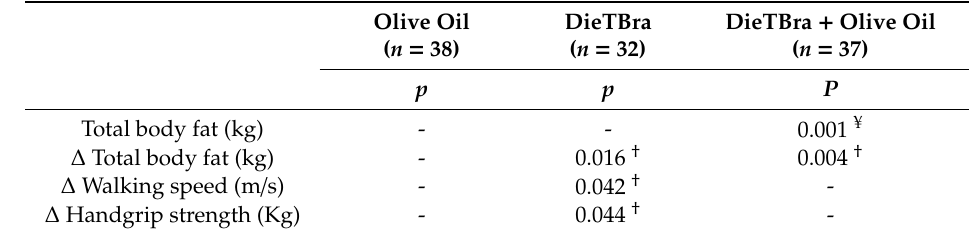
Table 5. Analysis of covariance for delta of outcome variables * with delta weight and delta time of sedentary behavior in intervention groups. Olive